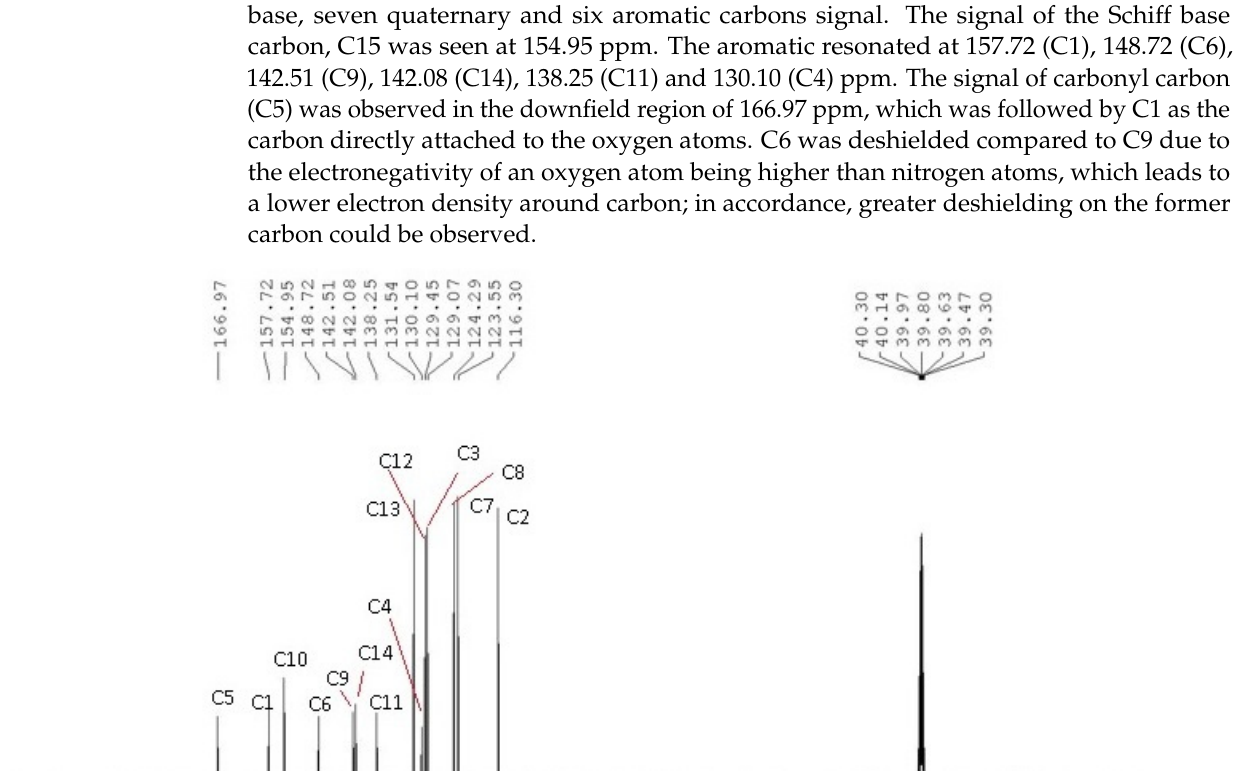
6 ) of compound 4a .